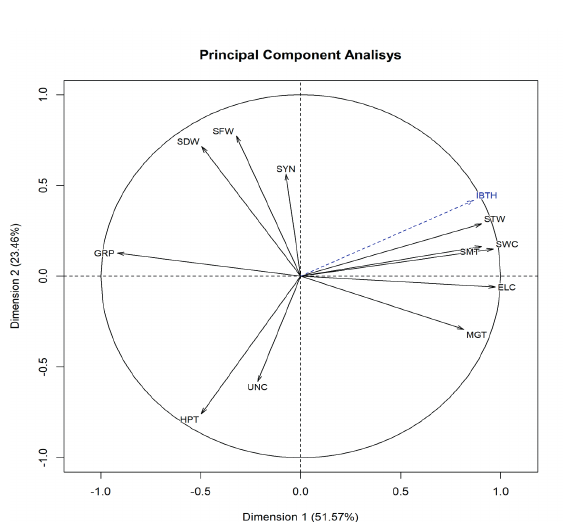
Figure 3. Principal Component Analysis from the variables in Jatropha curcas seeds after different